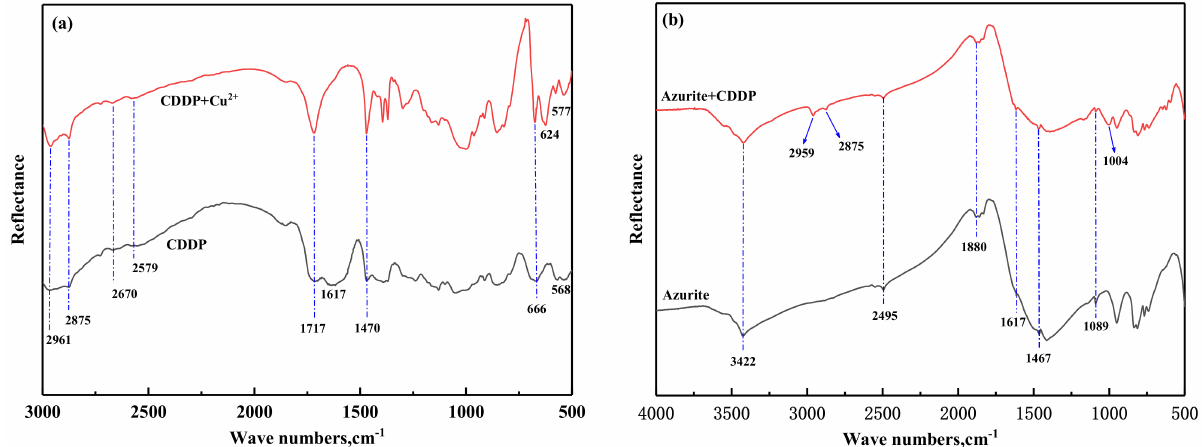
Figure 6. ( a ) FT-IR spectra of CDDP and CDDP+Cu 2+ ; ( b ) FT-IR spectra of azurite before and after interacting with CDDP.